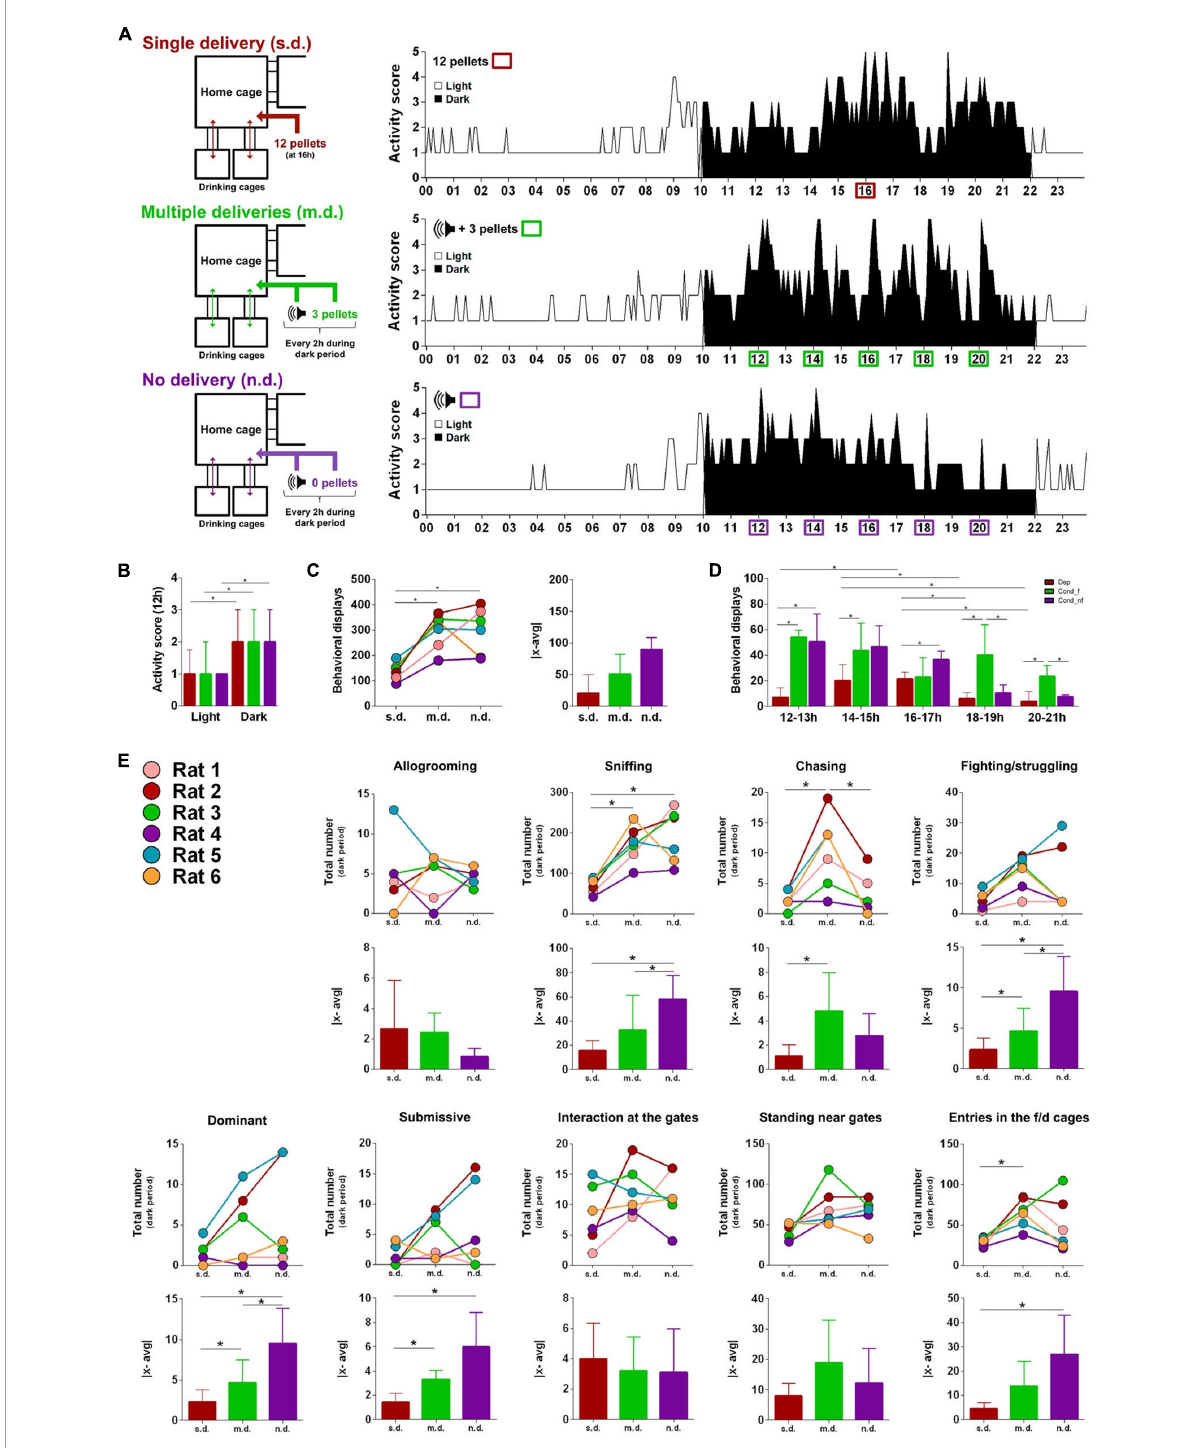
FIGURE2 Activity in the home cage: single and multiple deliveries conditions. (A) Representative graphs of the activity score of the six rats in the home cage, in the single delivery (s.d.; 2 pellets/rat at 16 h), multiple deliveries (m.d.; 1 pellet/2 rats every 2 h paired with a sonorous tone) and no delivery paradigms (n.d.; sonorous tone every 2 h); events are represent with a colored square; brown, green, and purple, respectively. (B) m.d. condition increased activity scores in the dark period but not in the light period. (C,D) m.d. deliveries condition significantly increased the number of behavioral displays without any evident effect on the dispersion of the groups; in the n.d. activity/displays decreased as the tone association extinguish. (E) Sniffing and chasing significantly increased (number and dispersion) in the m.d. condition. Results are presented as median and IQR; n = 6/group, * p < 0.05, Wilcoxon